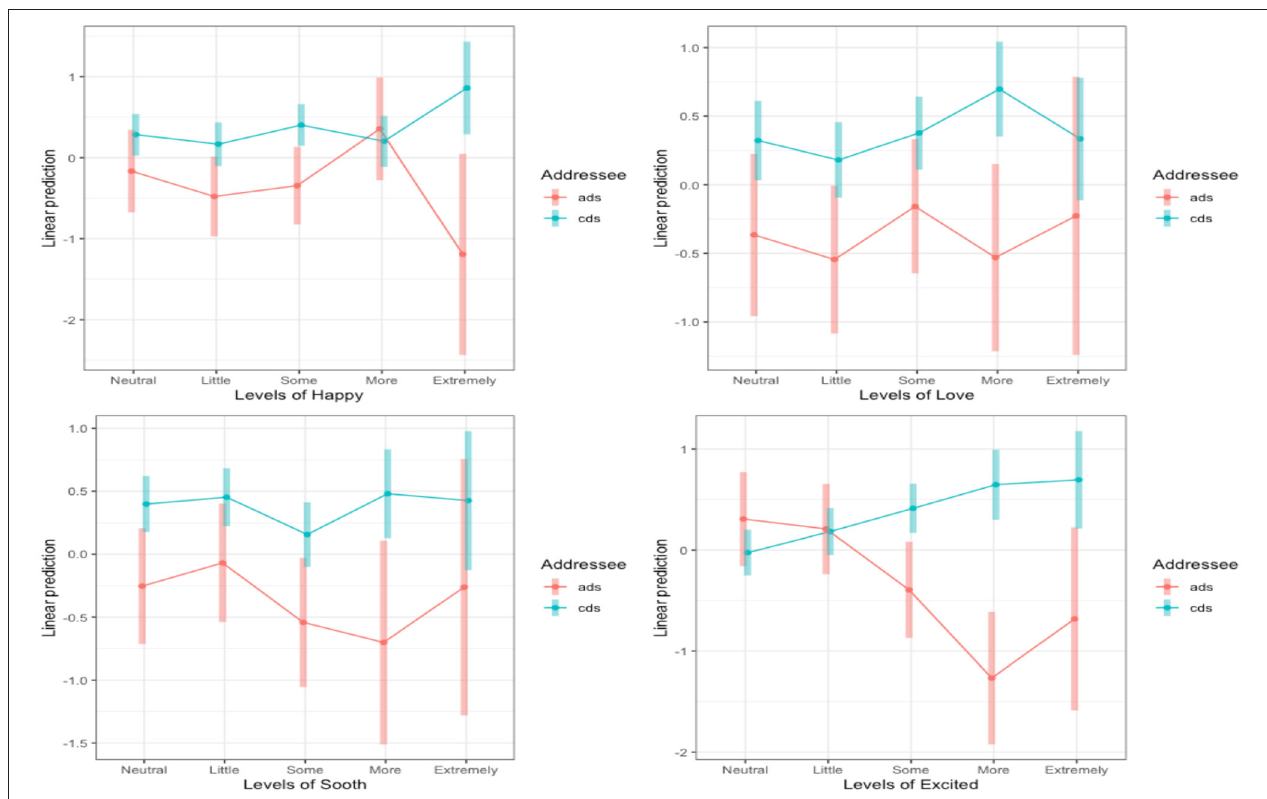
FIGURE 4 | Levels of sounded Happy (top left), sounded Loving (top right), sounds Soothing (bottom left), and sounded Excited (bottom right) for the interactions with Addressee in Experiment 2b. The log odds of each affect level are plotted on the y-axis and the shaded areas represent the 95% CIs. Only the interaction between Addressee and Excited was